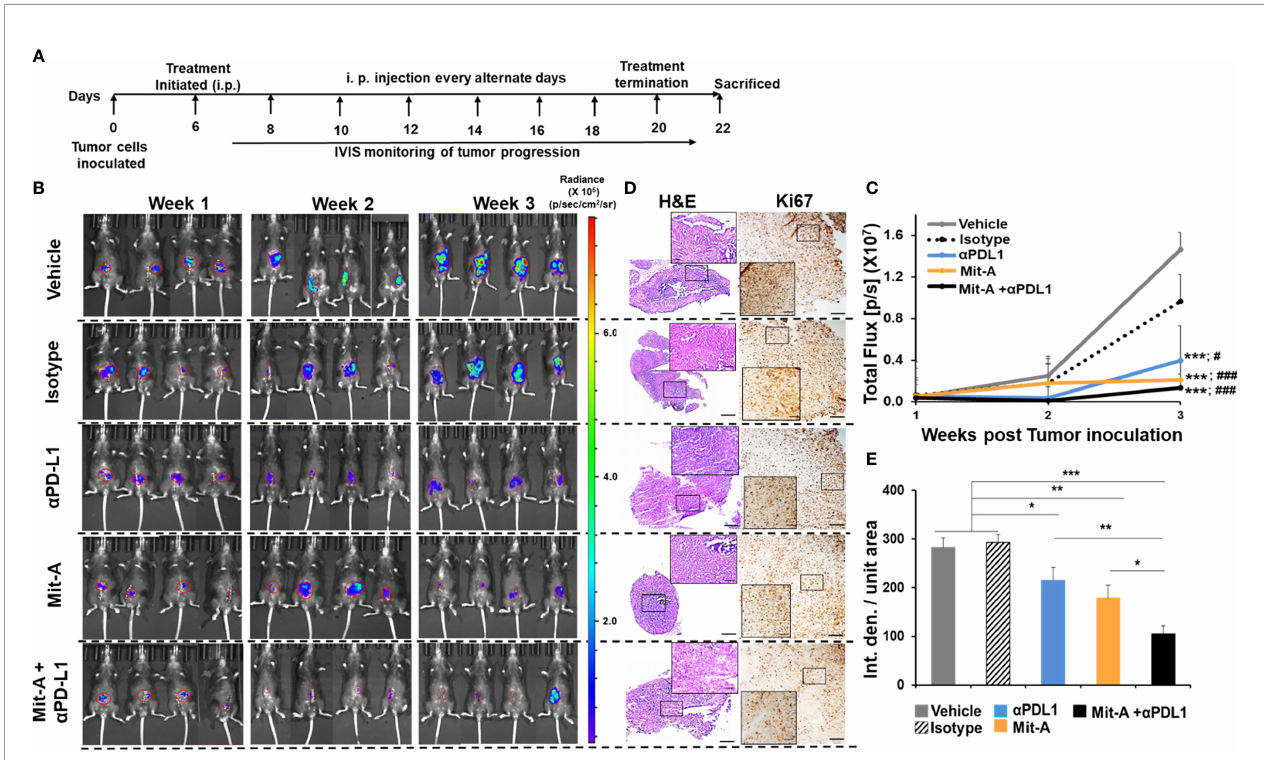
FIGURE 3 | Combination of Mit-A and a PD-L1 reduces the tumor burden in orthotopic MC38 tumor-bearing mice. (A) Treatment scheme. Approximately 6 to 8 weeks old (female) wild-type C57BL/6 mice were anesthesized with iso fl urane inhalation and the cecum was exposed via a lower abdominal incision.